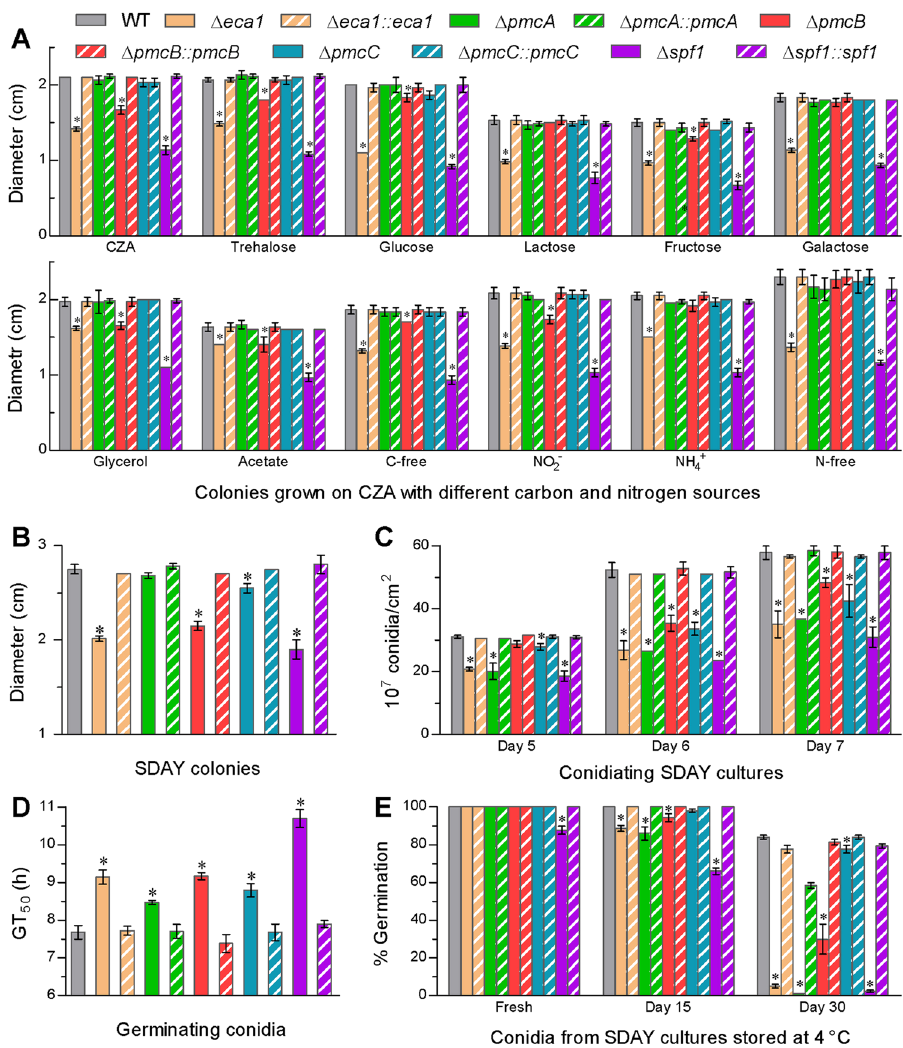
Figure 4. The CA pumps sustaining vegetative growth, conidiation capacity and conidial viability in B . bassiana . ( A , B ) Diameters of fungal colonies after 8 days of cultivation at 25 °C on the plates of minimal CZA, modified CZA media with different carbon and nitrogen sources and rich SDAY, respectively. Each colony was initiated with the spotting method. ( C ) Conidial yields quantified over the days of normal cultivation on SDAY plates spread with 100 µ l aliquots of conidial suspension for culture initiation. ( D ) Median germination time (GT 50 ) estimated as an index of conidial germination rate for each of the fungal strains. ( E ) Germination percentages of conidia taken from fresh 7-day-old SDAY cultures and the same cultures stored at 4 °C for 15 and 30 days, after 24 h incubation at 25 °C. The asterisked bars in each bar group differ significantly from those unmarked (Tukey’s HSD, P < 0.05). Error bars: SD from three